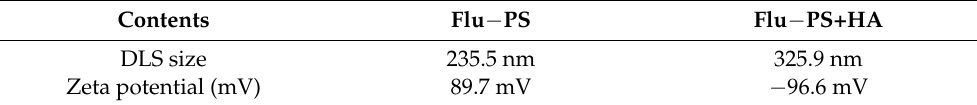
Table 1. The particle size and zeta potential of PS and PS+HA.